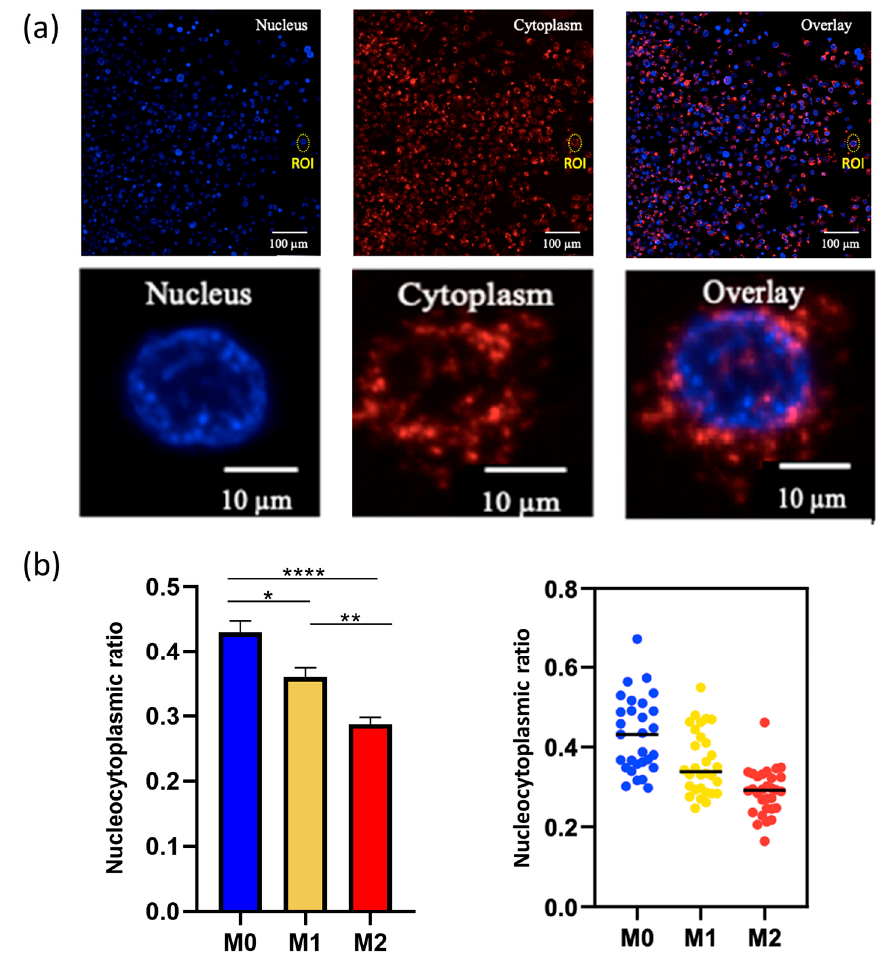
Figure 3. Macrophages nucleocytoplasmic ratio. ( a ) Using ImageJ software and selecting regions of interest (ROI), the nucleocytoplasmic ratio values (nucleus/cytoplasm volumes) were calculated for 30 cells/macrophage phenotype. ( b ) Macrophage nucleocytoplasmic ratio values (M0 in blue, M1 in yellow, and M2 in red). Mean ± SD and statistical analysis (Kruskal–Wallis, * p < 0.01; ** p < 0.001; **** p < 0.0001).